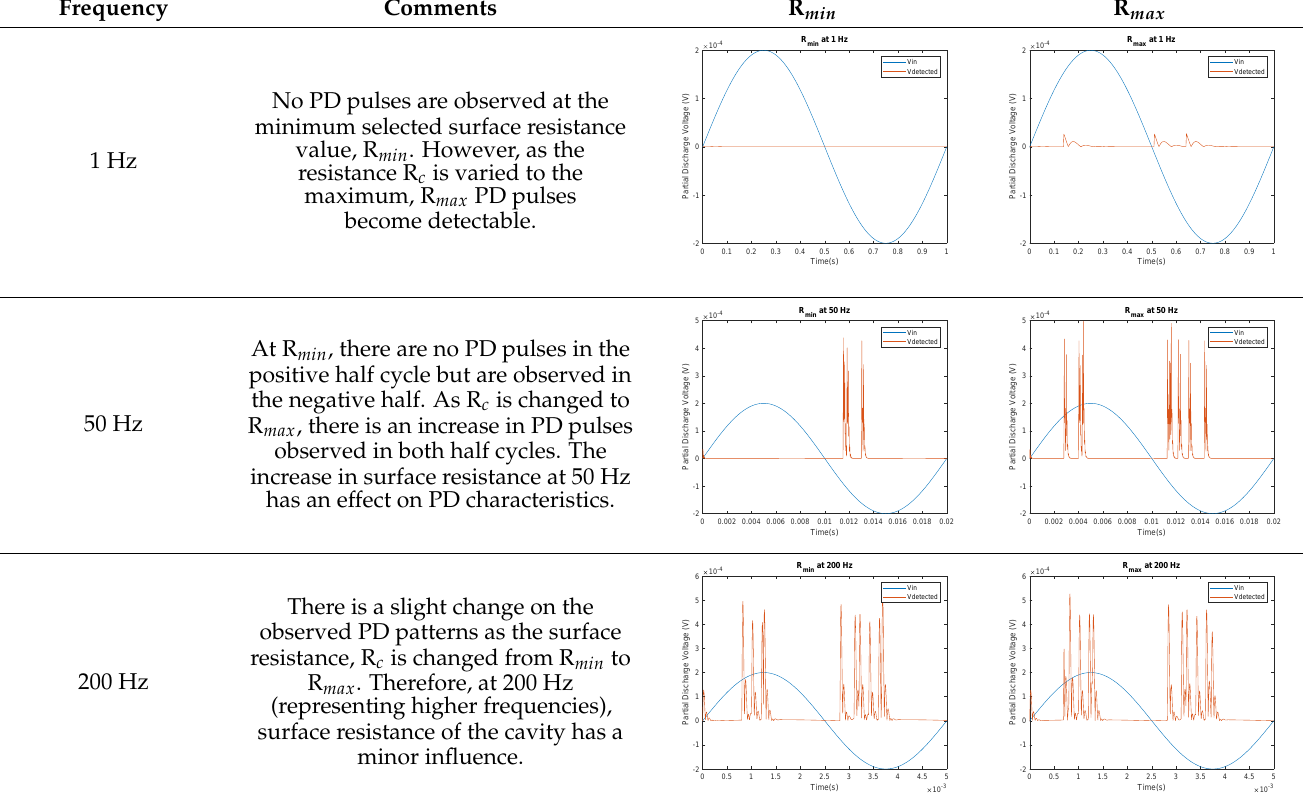
Table 3. Cavity surface resistance influence on PD characteristics at different frequencies. R c values used: R min is 6.0 × 10 9 Ω and R max is 6.0 × 10 12 Ω as obtained from Hudon et al. [55] and Morshuis [56].